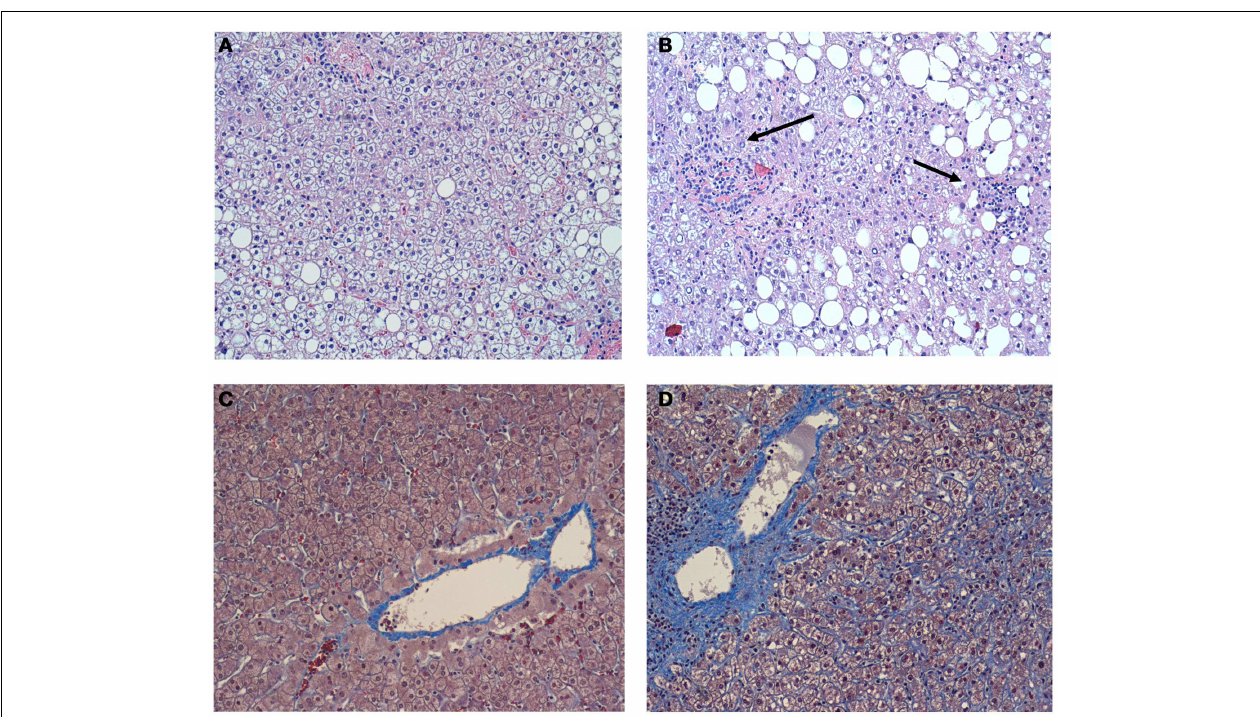
of the liver without pericellular fibrosis in the individual without OSA. Masson trichrome X 100; (D) A representative image of the liver in the individual with OSA and severe nocturnal oxyhemoglobin desaturation. Masson trichrome X 100. Prominent pericellular perisinusoidal fibrosis is present. Collagen depositions are stained in blue and have chicken-wire appearance. Reproduced with permission from Polotsky et al.